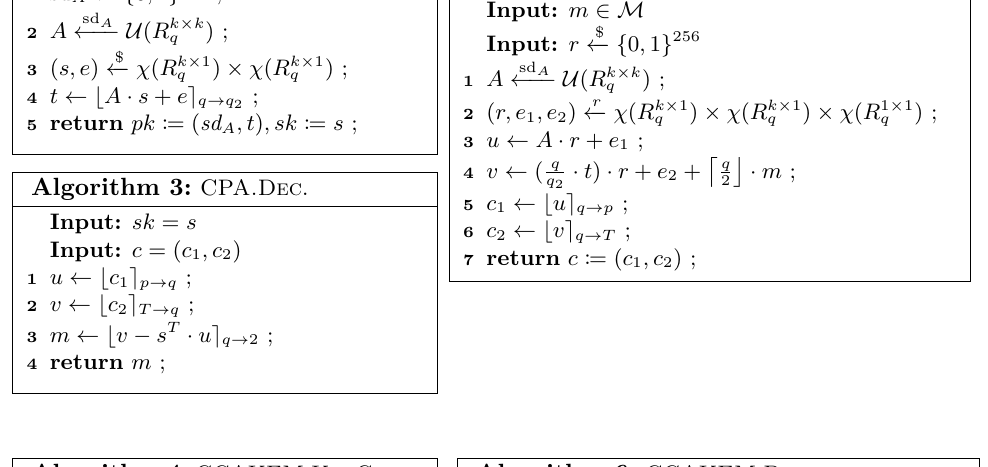
Algorithm 4: CCAKEM.KeyGen .